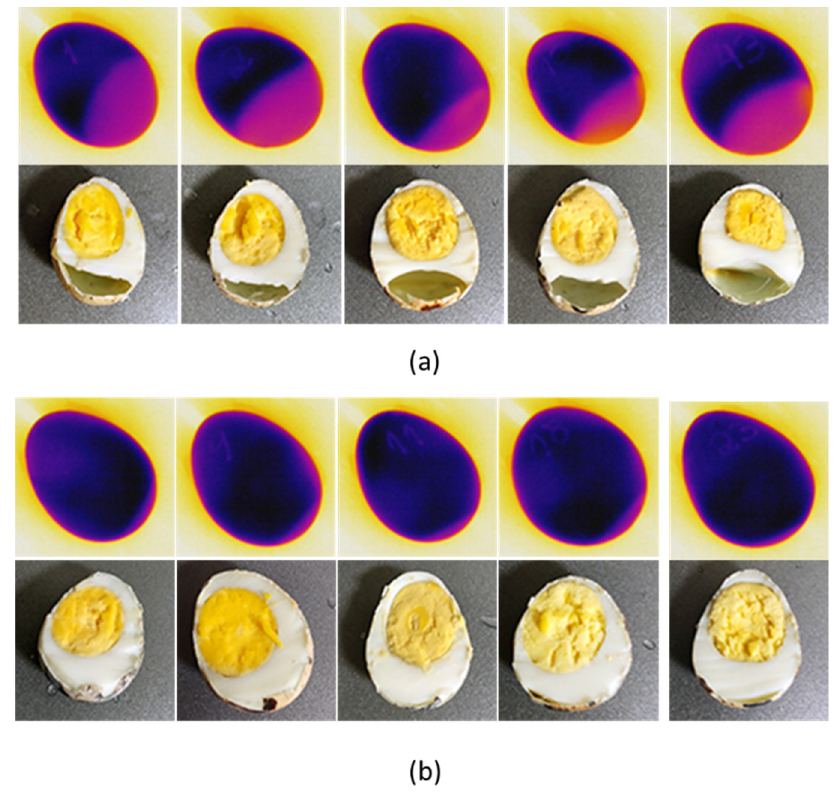
Figure 12. Egg assessment by boiling eggs and the corresponding thermal picture. ( a ) Nonfresh eggs present a large air cell. ( b ) Still fresh eggs show no chamber or reduced size compared to nonfresh eggs.